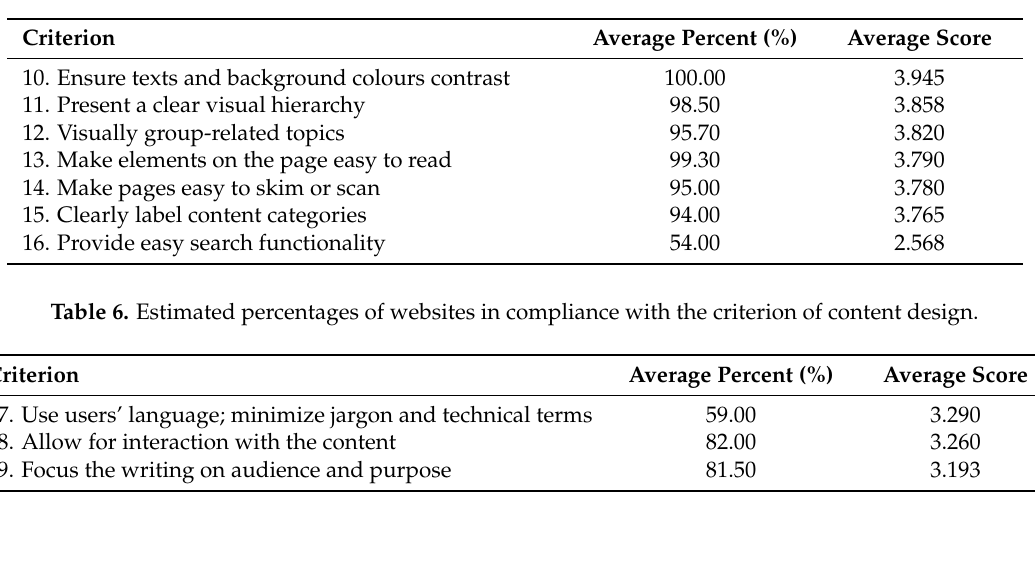
Table 5. Estimated percentages of websites in compliance with the criterion of information architecture.